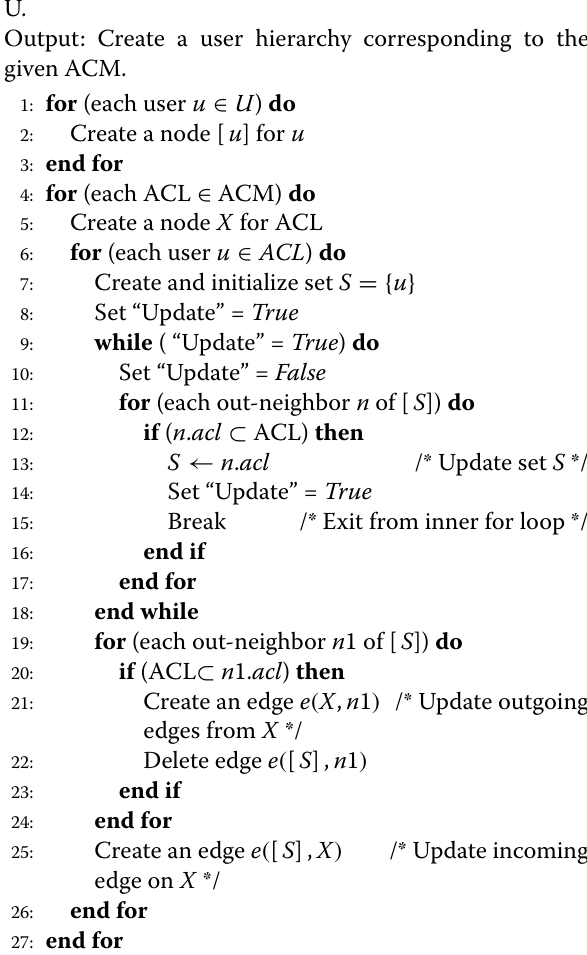
Algorithm 2 Create _ UHier ( ACM , U )